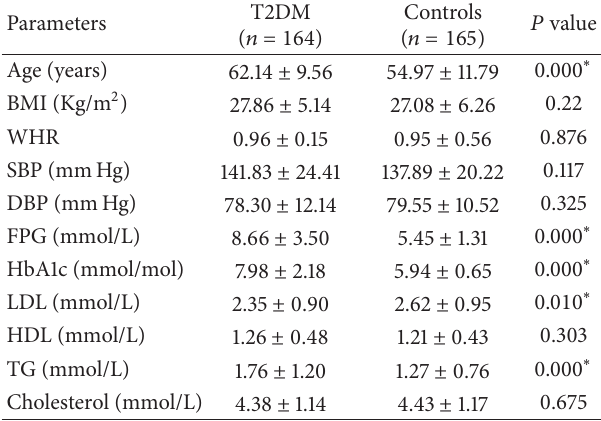
Table 1: Clinical and biochemical characteristics between T2DM and control